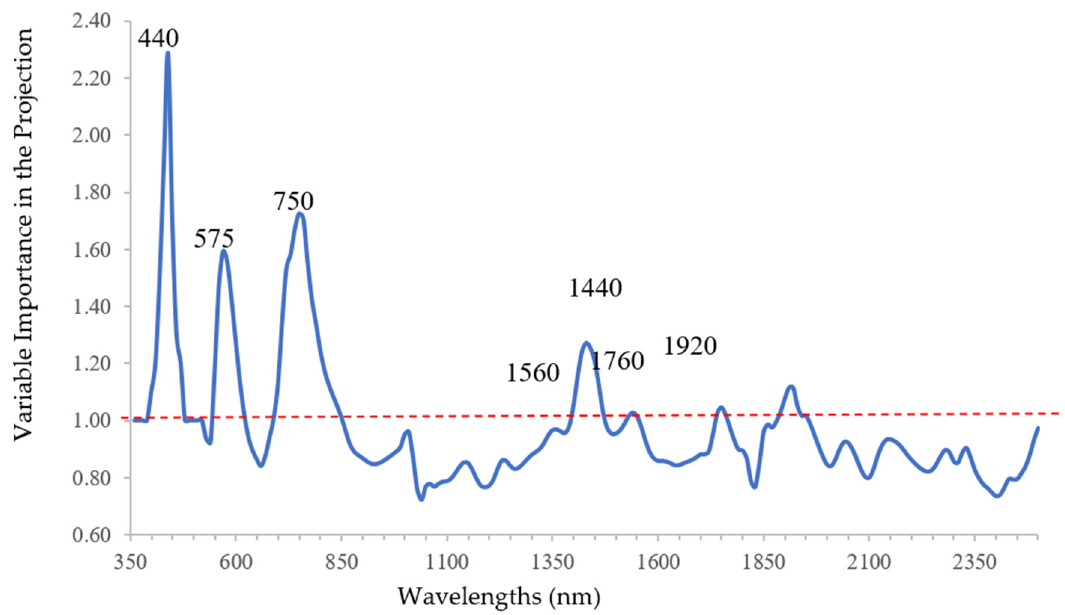
Figure 2. Variable Importance in the Projection (VIP) profile of the selected Partial Least Square Regression (PLSR) model predicting DNA content. Relative maximum peaks are marked. Table 2. Statistics of Partial Least Square (PLS) by pre-processing method, analysis of residuals (normality tests).